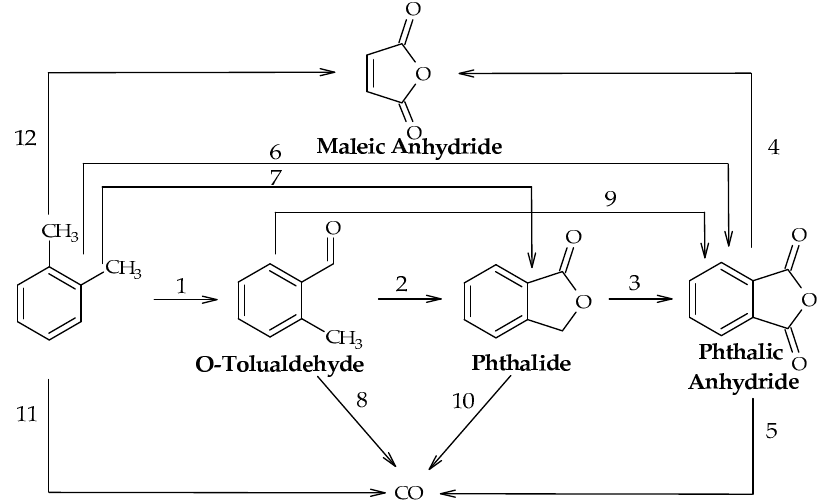
Figure 1. Reaction scheme for o-xylene oxidation. Adapted with permission from [13], copyright 2008, Elsevier.